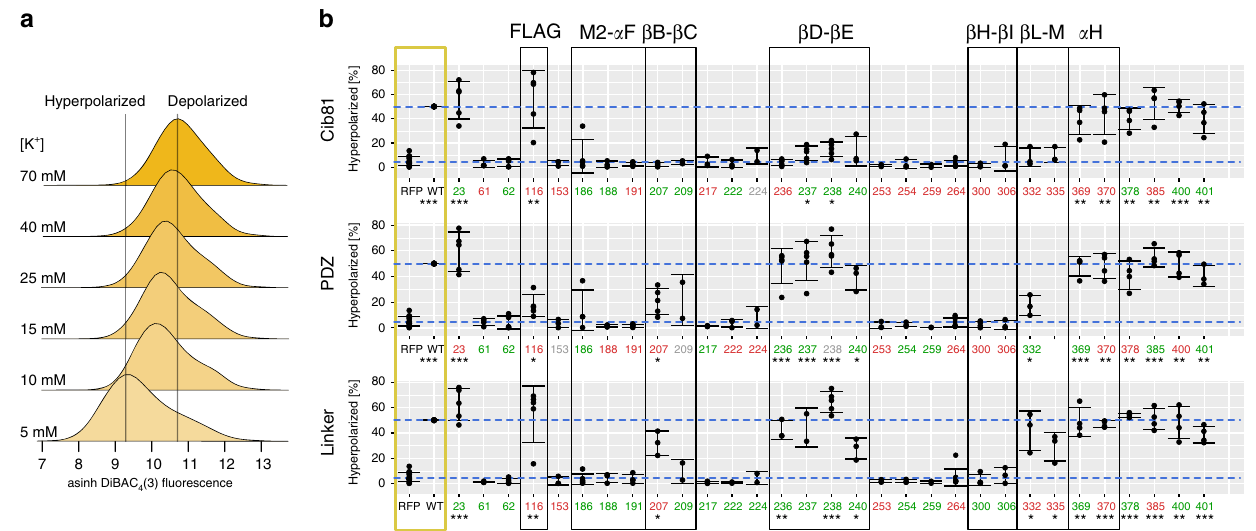
Fig. 5 Domain insertion impact on Kir2.1 function. a Stacked histograms of population-level DiBAC 4 (3) fl uorescence (hyperbole arcsine transformed) in HEK293FT cells expressing WT Kir2.1 as a function of external K + (concentration indicated on the left). Increasing K + depolarizes the cells, resulting in less membrane partitioning of the dye, thus increasing measured fl uorescence. b The percentage of hyperpolarized cells expressing the indicated Kir2.1